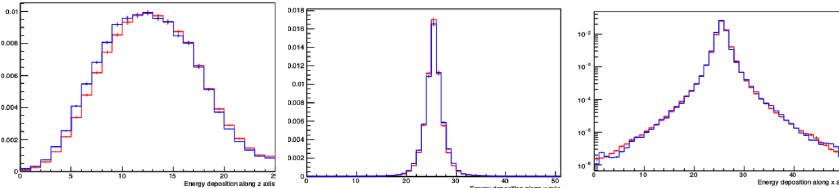
Figure 3. Calorimeter energy response. The GAN prediction is in blue, Monte Carlo in red. (left) Along the detector longitudinal plane. (center) Along the detector transverse plane in linear scale and (right) logarithmic